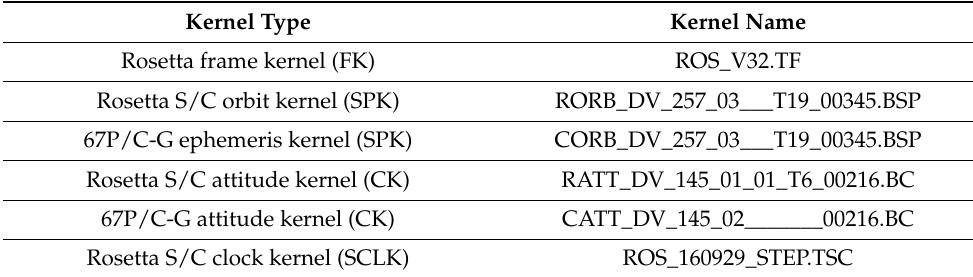
Table 4. Main SPICE kernels used in this study.